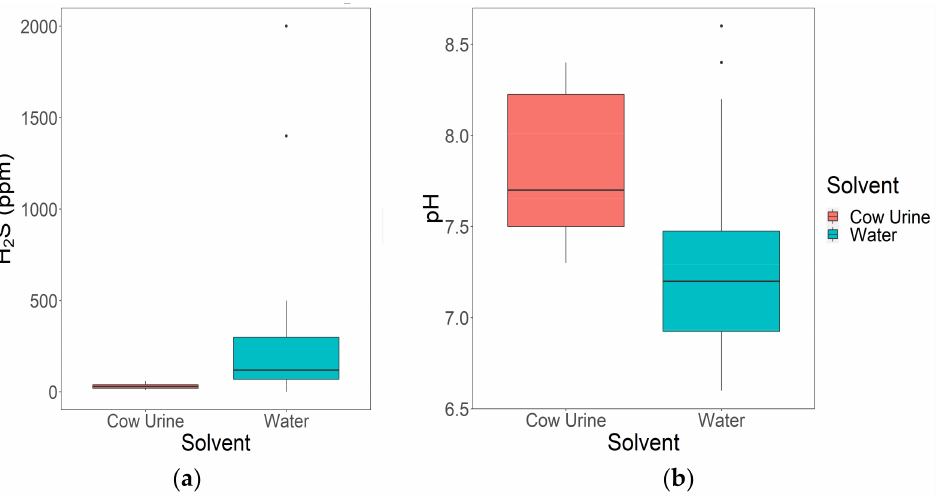
Figure 3. ( a ) Effect of solvents on H 2 S content in biogas and ( b ) on pH of digesters visited in the field study using either cow urine or water as